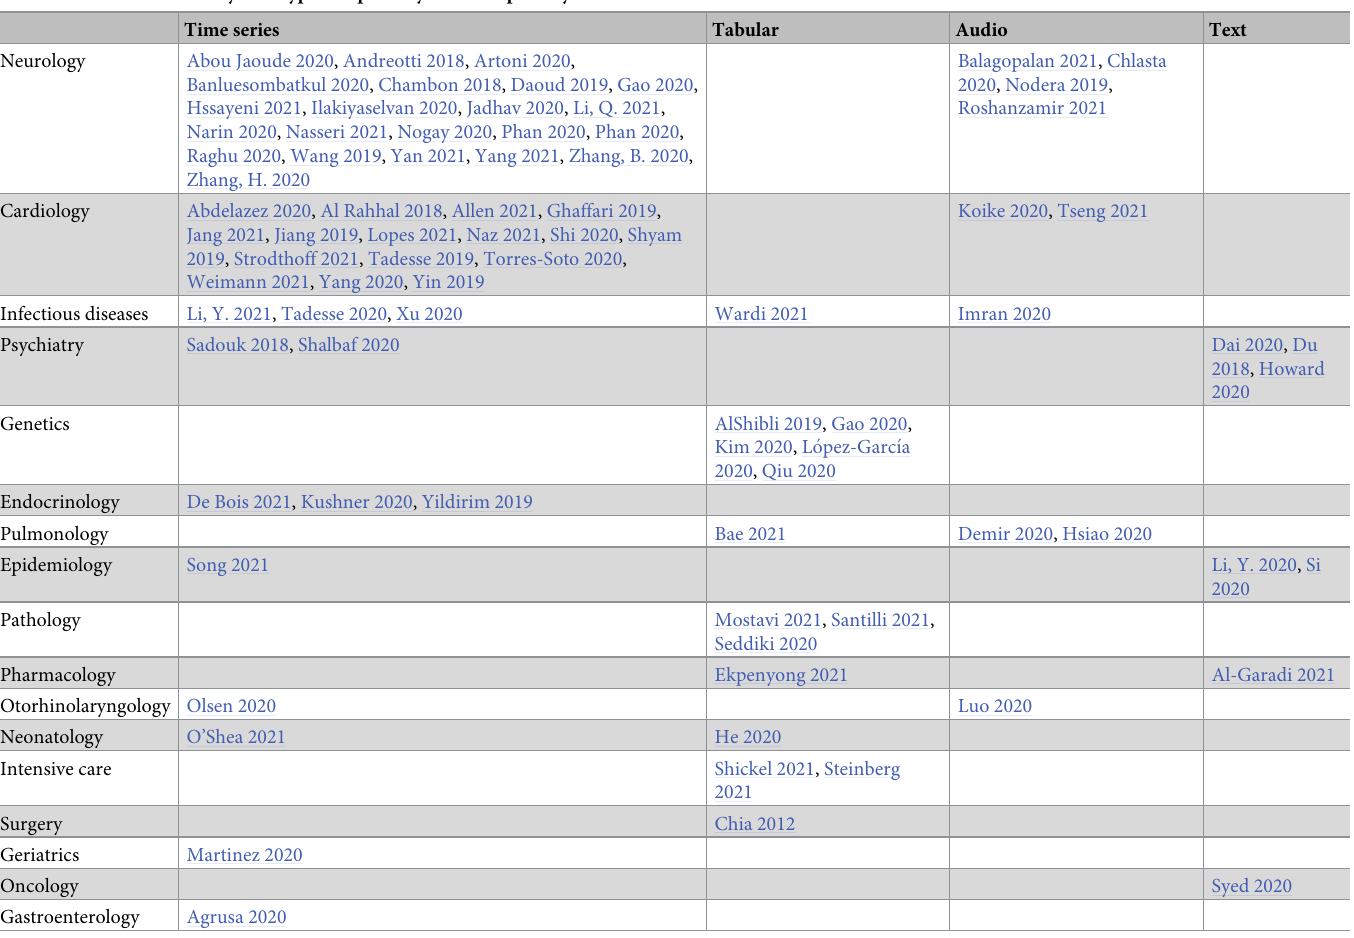
Table 1. Included articles by data type and primary medical